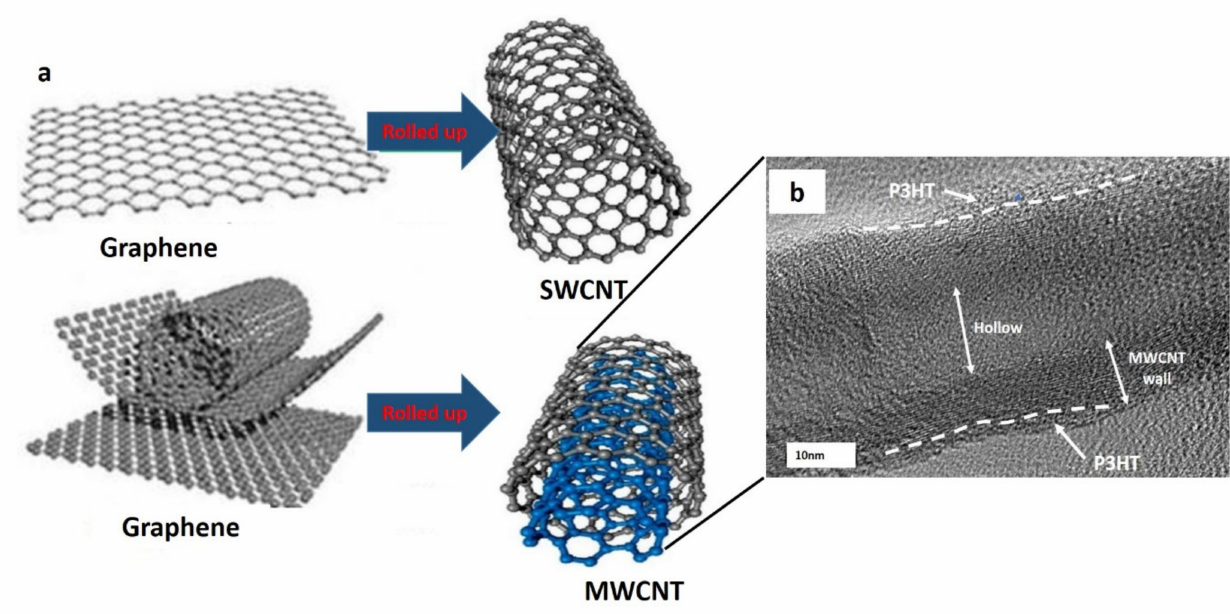
Figure 1. ( a ) Schematic diagram of SWCNT and MWCNT (reproduced from [35]) and ( b ) the MWCNT wrapped with poly(3-hexylthiophene). Reproduced from